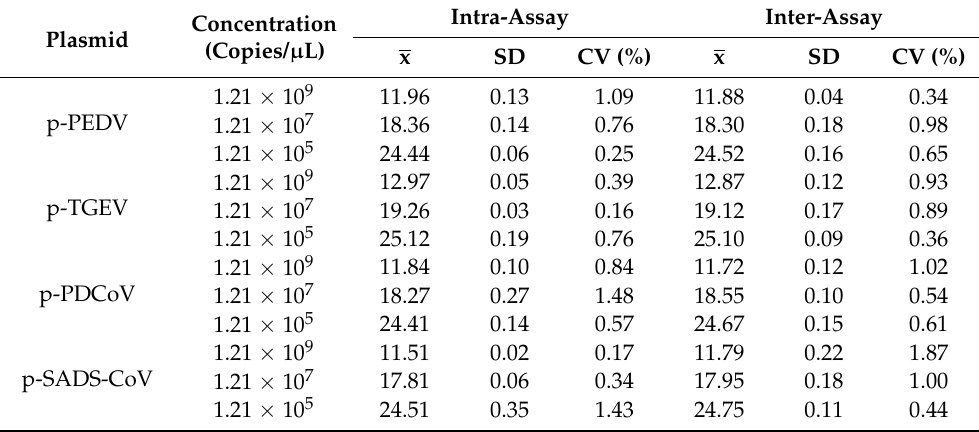
Table 3. The Ct values and coefficients of variation for repeatability analysis.